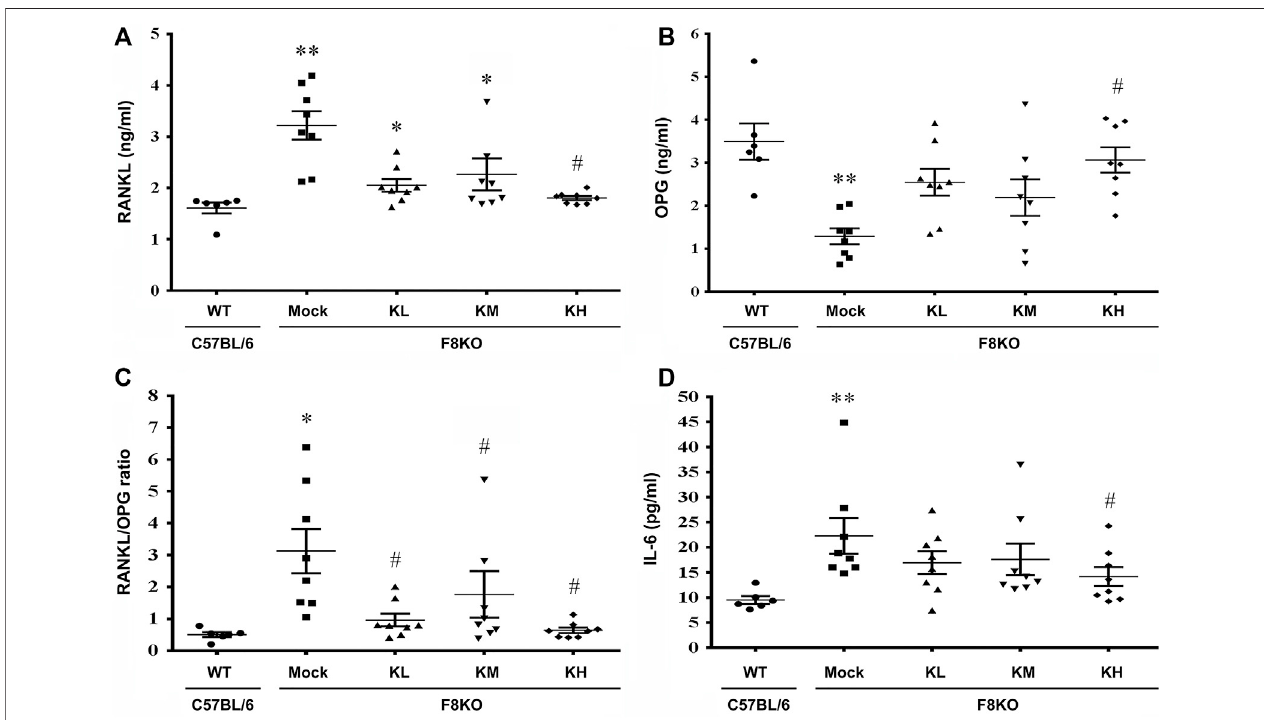
FIGURE 6 | Effects of KP treatment on the serum RANKL/OPG ratio and proin fl ammatory IL-6 cytokine levels. F8KO mice at 20 weeks of age were orally administereddifferentdosagesofKPsfor8 weeks( n =8).Attheendoftreatment,mousebloodwascollectedforboneresorptionandboneformationmarkerdetection. Thequantitativedatashowthelevelsof (A) receptoractivatorofnuclearfactor κ -Bligand(RANKL), (B) osteoprotegerin(OPG), (C) RANKL/OPGratio,and (D) interleukin- 6 (IL-6) in the KP-treated groups at different dosages. * p < 0.05, ** p < 0.01 vs. WT group; # p < 0.05 vs. mock group.